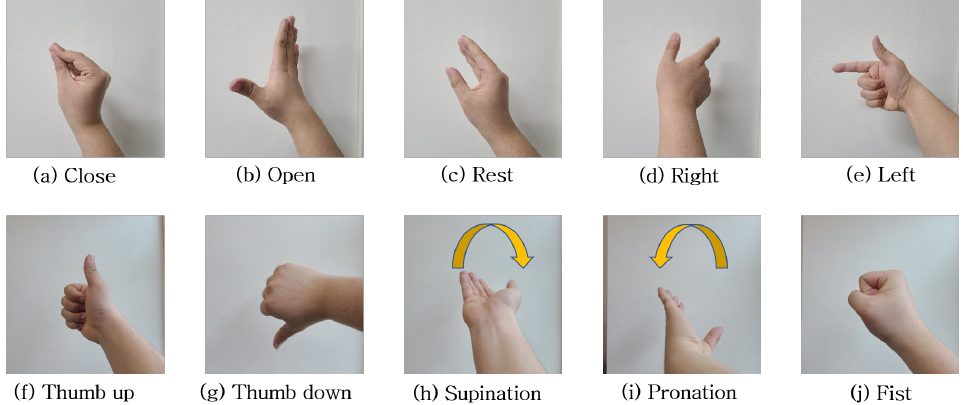
Figure 5. Dynamic hand gestures used in the proposed